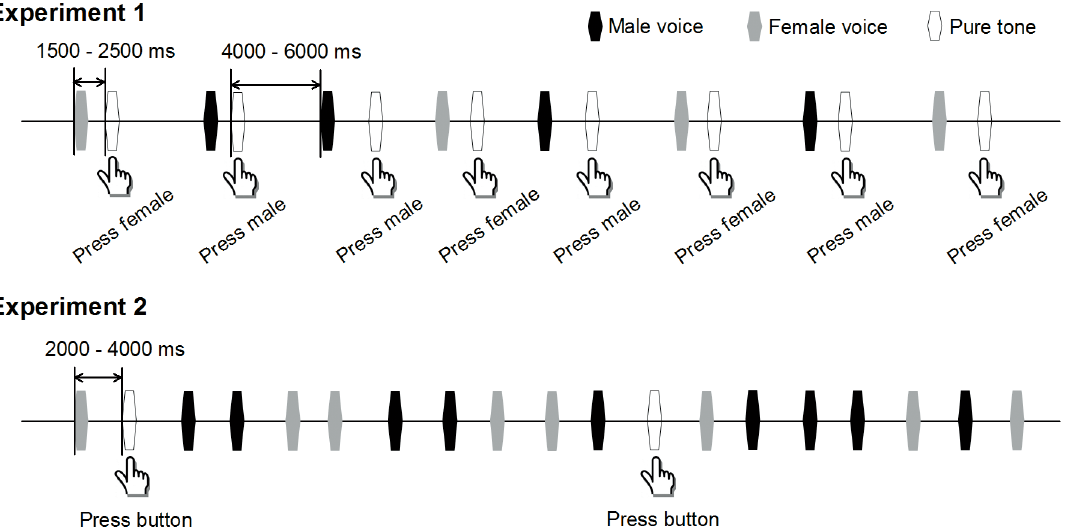
Figure 2. Experimental paradigms. In Experiment 1, the 9 male voices and 9 female voices were pseudo-randomly presented to participants with equal probability. A pure tone sound was presented after each voice. Participants were instructed to press the female or male key when hearing the pure tone to indicate the gender information of the voice just before the pure tone. In Experiment 2, the 9 male voices and 9 female voices, and a pure tone stimulus were pseudo-randomly presented to participants. Participants were instructed to press the key when hearing the pure tone stimulus.